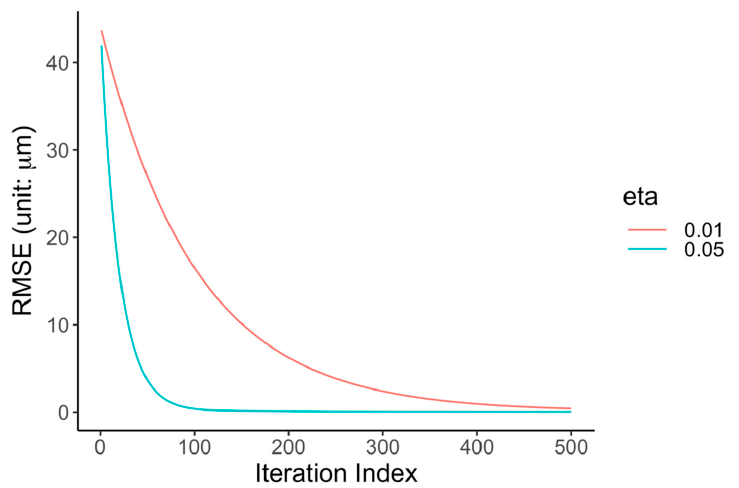
Figure 7. RMSE over iterations with two different values of eta for training data K23.